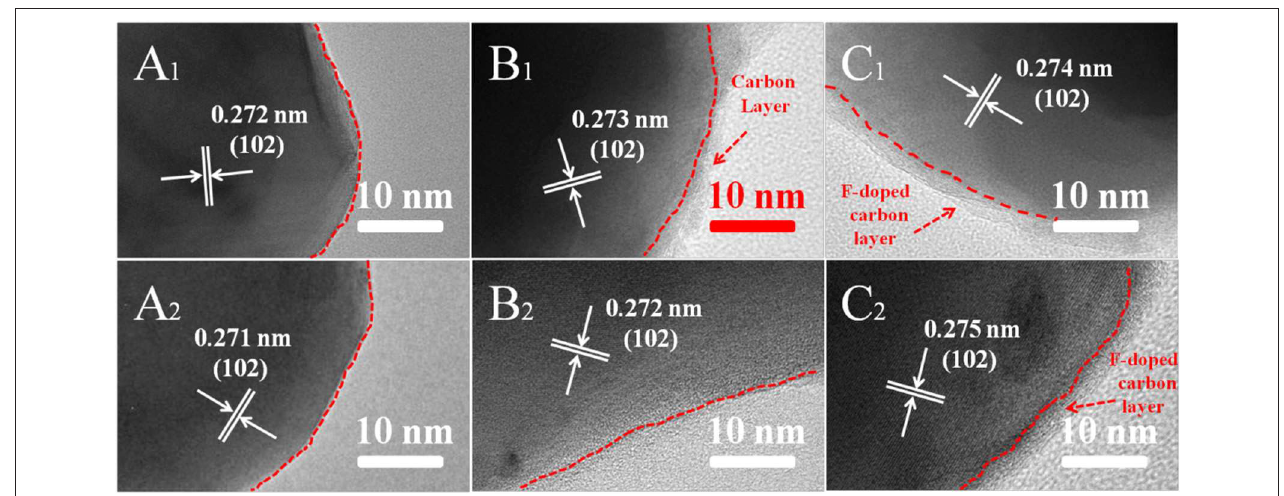
FIGURE 8 | TEM images of all samples of pure LFP: (A 1 ) after 300 cycles, (A 2 ) after 500 cycles, LFP/C: (B 1 ) after 300 cycles, (B 2 ) after 500 cycles and LFPF/CF: (C 1 ) after 300 cycles, (C 2 ) after 500 cycles at 5C rate, respectively.